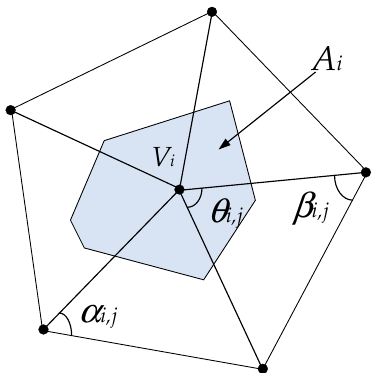
Figure 3. Diagram of the Laplace operation for vertices in a mesh.